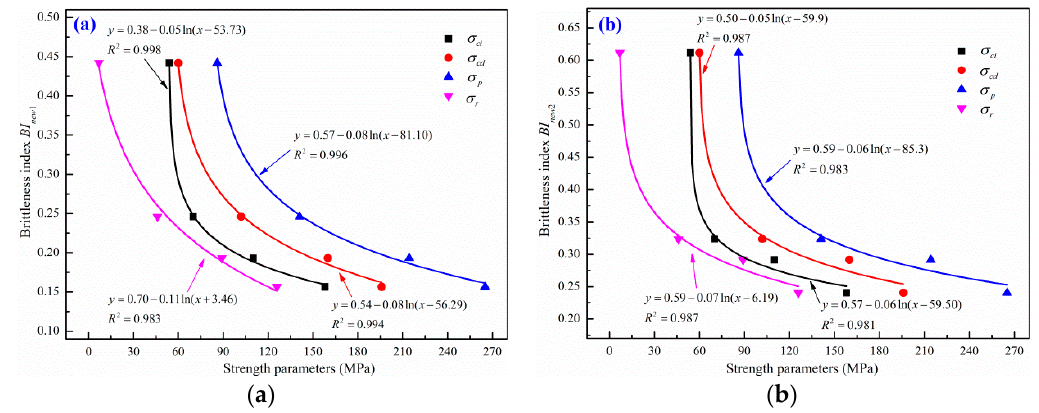
Figure 13. Correlations between strength characteristics and brittleness indexes ( a ) BI new